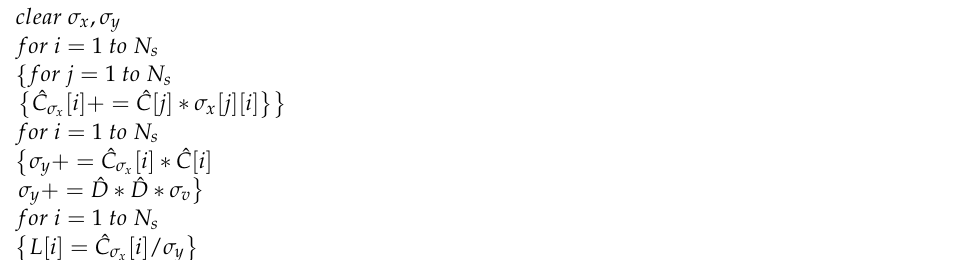
Algorithm 5: Compute the Kalman Gain matrix, L